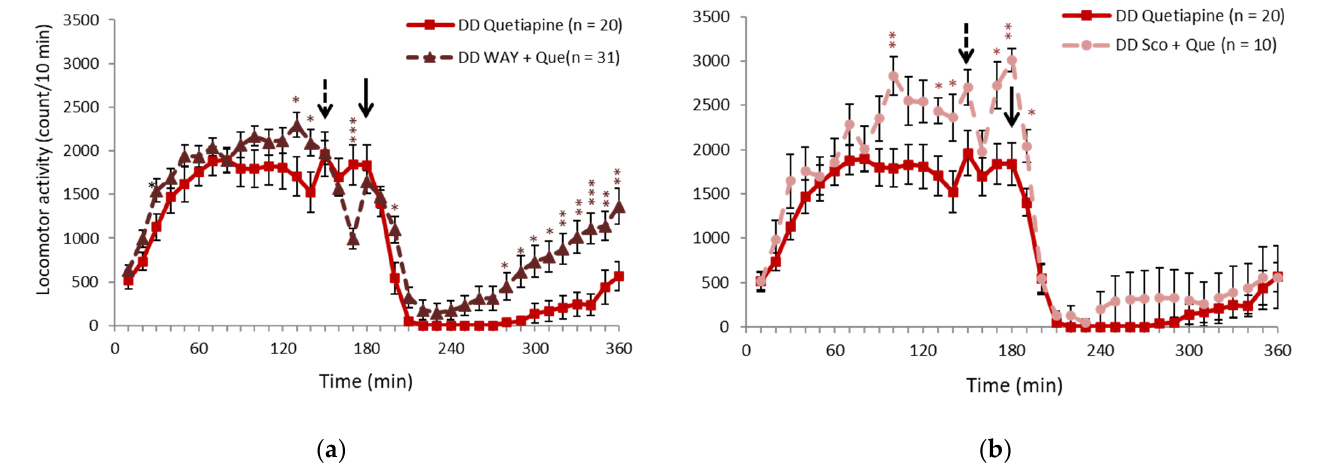
Figure 3. Effects of quetiapine on locomotor activity when 5-HT 1A and cholinergic receptor activity is suppressed. ( a , b ) Changes in locomotor activity induced by ( a ) 1 mg/kg WAY100635 and ( b ) scopolamine in DD mice 30 min before quetiapine administration. The solid arrows indicate the quetiapine injection time. The dashed arrows indicate the WAY100635 and scopolamine injection time. * p < 0.05, ** p < 0.01, *** p < 0.001, compared with quetiapine (Student’s t -test). The graphs show the number of animals per group. The data are expressed as mean ± SEM. 5-HT, 5-hydroxytryptamine (serotonin); DD, dopamine-deficient mice.